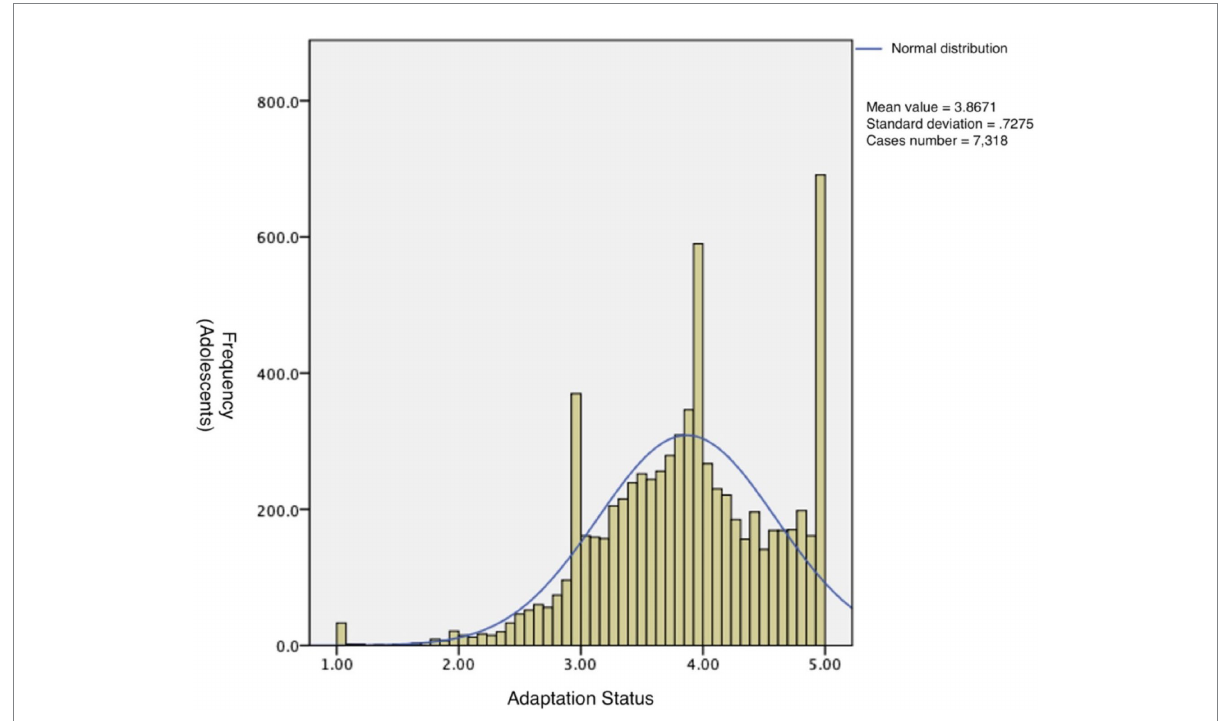
FIGURE 1 Adaptation status of Chinese adolescents. Horizontal coordinates describe the frequency of adolescents. And, the vertical coordinates describe the adaptation